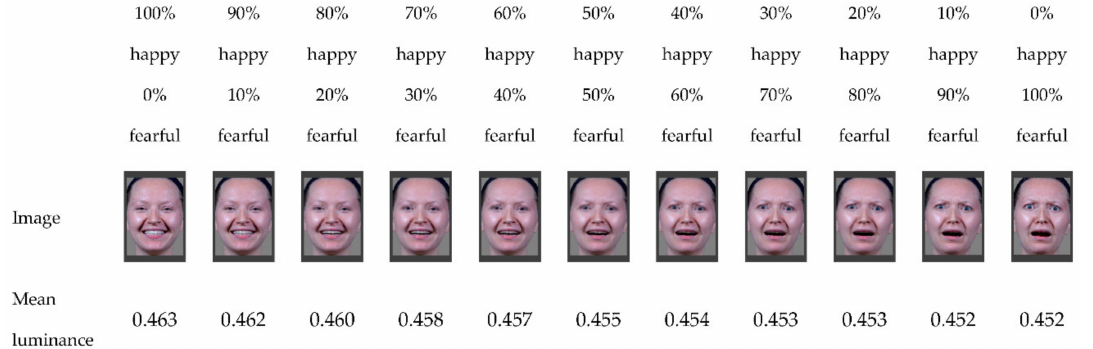
Figure 1. Continuum between 100% happy and 100% fearful facial expressions in 10% increments. Mean luminance (from 0.000 to 1.000) for each image was obtained using GIMP version 2.10.12 [33]. In order to make the presentation of the morphed expressions more natural and dynamic, animations from our series of still morphs were generated, once again using FantaMorph 5 [31]. The animations depicted a continuous formation of each morphed face as well as the 100% happy face over the course of 500 ms (15 frames) from a neutral facial expression (for an example, see Figure 2).